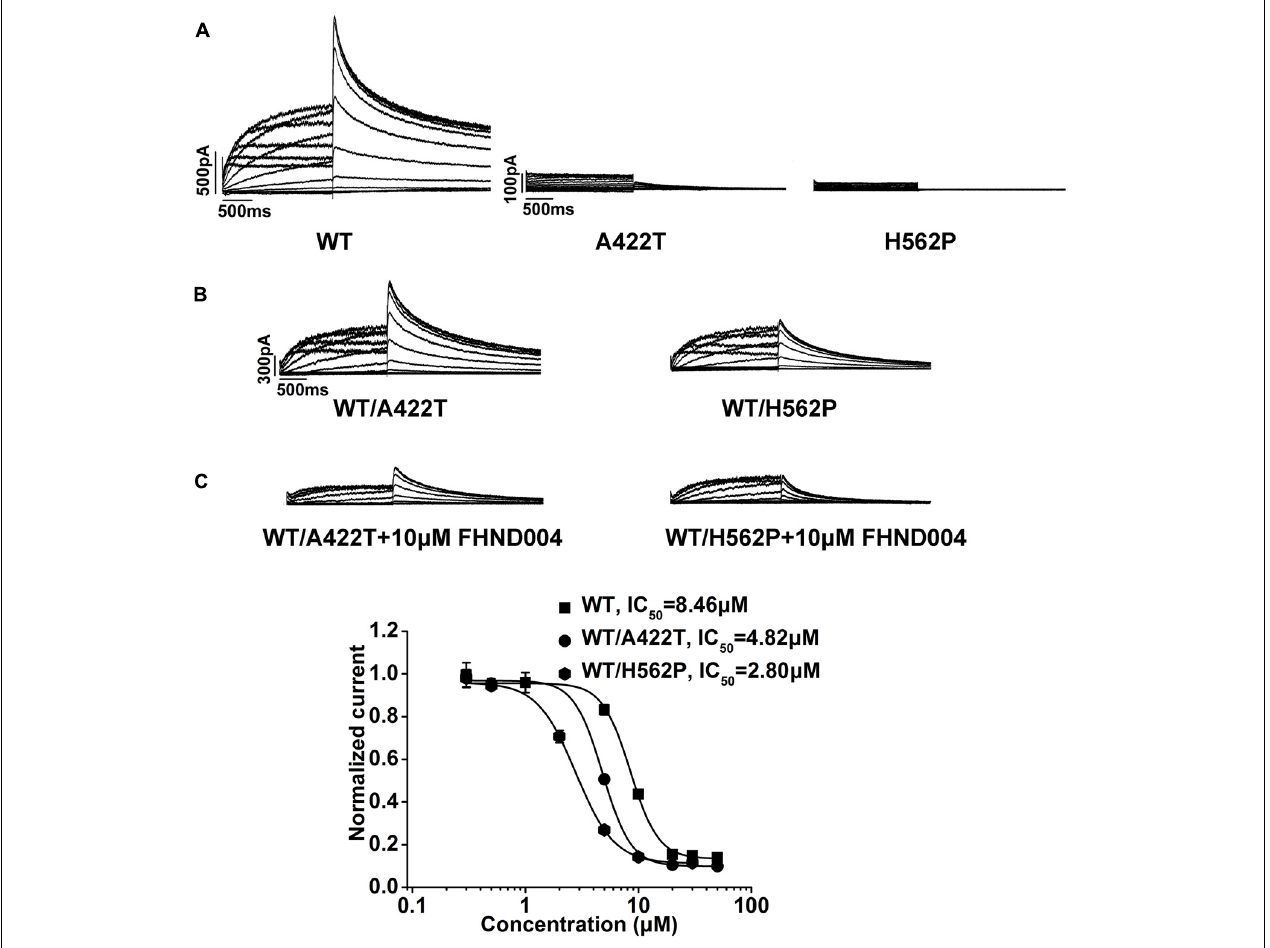
FIGURE 5 | Effects of A422T and H562P mutations on FHND004-induced inhibition. (A) Representative current traces recorded from HEK293 cells expressing WT-hERG, A422T-hERG, and H562P-hERG K + channels, respectively. (B) Representative current traces recorded from HEK293 cells expressing WT/A422T- and WT/H562P-hERG K + channels in the absence of 10 µ M FHND004. (C) Representative current traces recorded from HEK293 cells expressing WT/A422T- and WT/H562P-hERG K + channels in the presence of 10 µ M FHND004 and concentration–response relationships fitted with logistic equation for block of WT-, WT/A422T-, and WT/H562P-hERG tail currents by FHND004 with the same voltage protocol shown in Figure 1E ( n ≥ 6 per data point), and the slope factors are 3.50, 3.45, and 2.55,